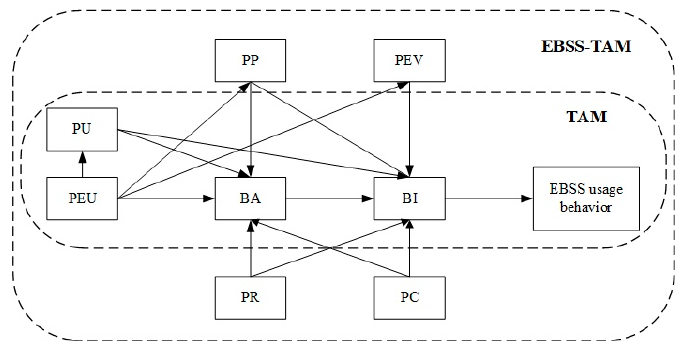
Figure 1. Conceptual model.